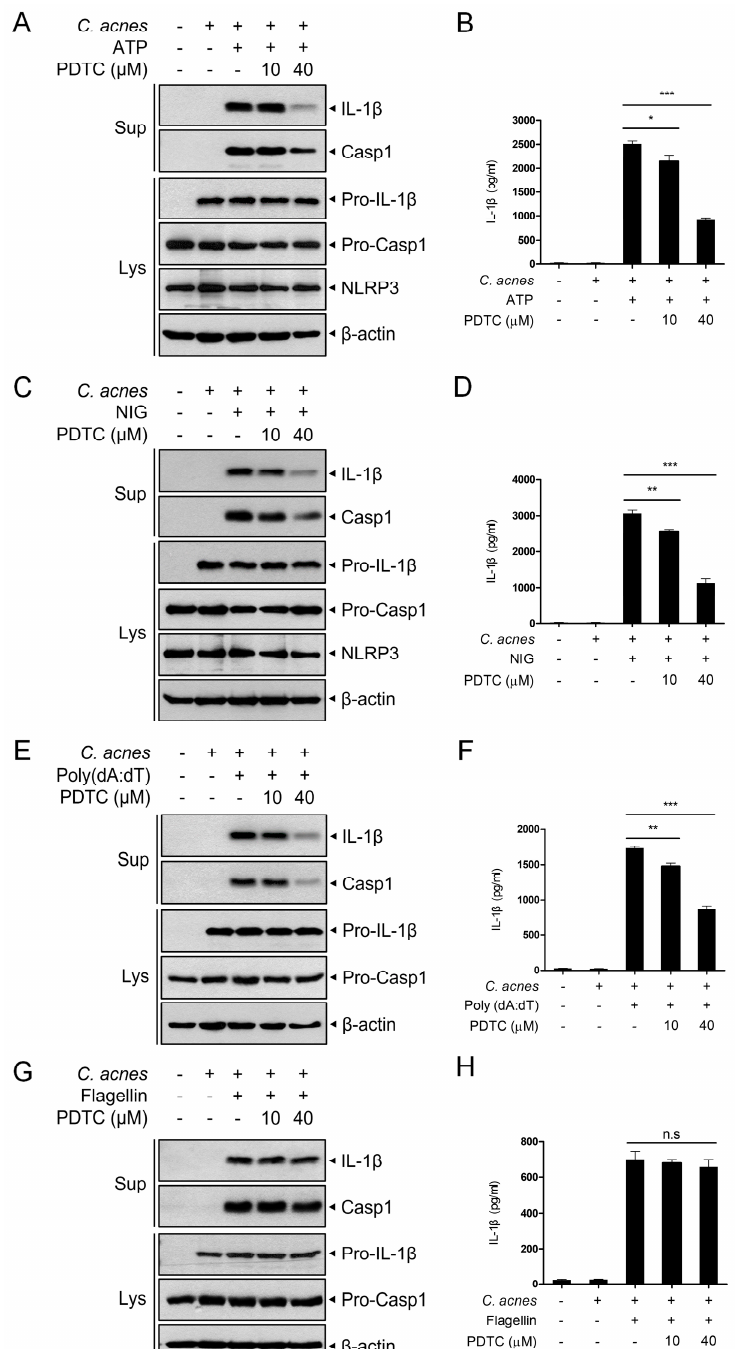
Figure 4. Inhibitory effects of PDTC on C. acnes -induced inflammasome activation. ( A – D ) Mouse BMDMs were primed with heat-killed C. acnes (1 × 10 6 CFU/mL) for 3 h and then treated with PDTC (10 μ M and 40 μ M) for 30 min before either ATP (5 mM) or nigericin (10 μ M) incubation for 1 h. Culture supernatants (Sup) and cell lysates (Lys) were immunoblotted with anti-IL-1 β , anti-caspase-1 and anti-NLRP3 antibodies ( A , D ). The secreted IL-1 β level was measured using ELISA ( B , C ). ( E – H ) Mouse BMDMs were primed with heat-killed C. acnes (1 × 10 6 CFU/mL) for 3 h and then treated with PDTC (10 μ M and 40 μ M) for 30 min before poly (dA:dT) (10 μ g/mL) transfection with lipofectamine 3000 or flagellin treatment (5 μ g/mL) for 4 h. Culture supernatants (Sup) and cell lyastes (Lys) were immunoblotted with the indicated antibodies ( E , G ). The secreted IL-1 β level was measured using ELISA ( F , H ). The results are represented as the means ± SDs of three independent experiments. * p < 0.05, ** p < 0.01, *** p < 0.001; n.s, nonsignificant.